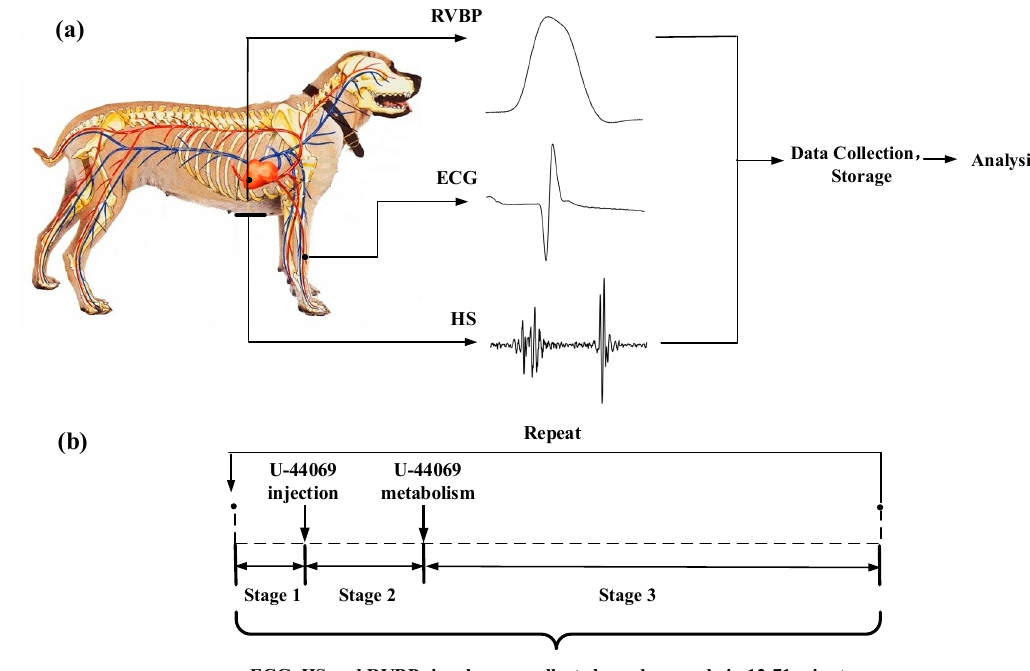
Figure 1. Schematic diagram of the measurement system and experimental procedure; ( a ) experiment setup; ( b )experimentalprocedure.ECG:Electrocardiography; HS:HeartSound; RVBP:RightVentricular Blood